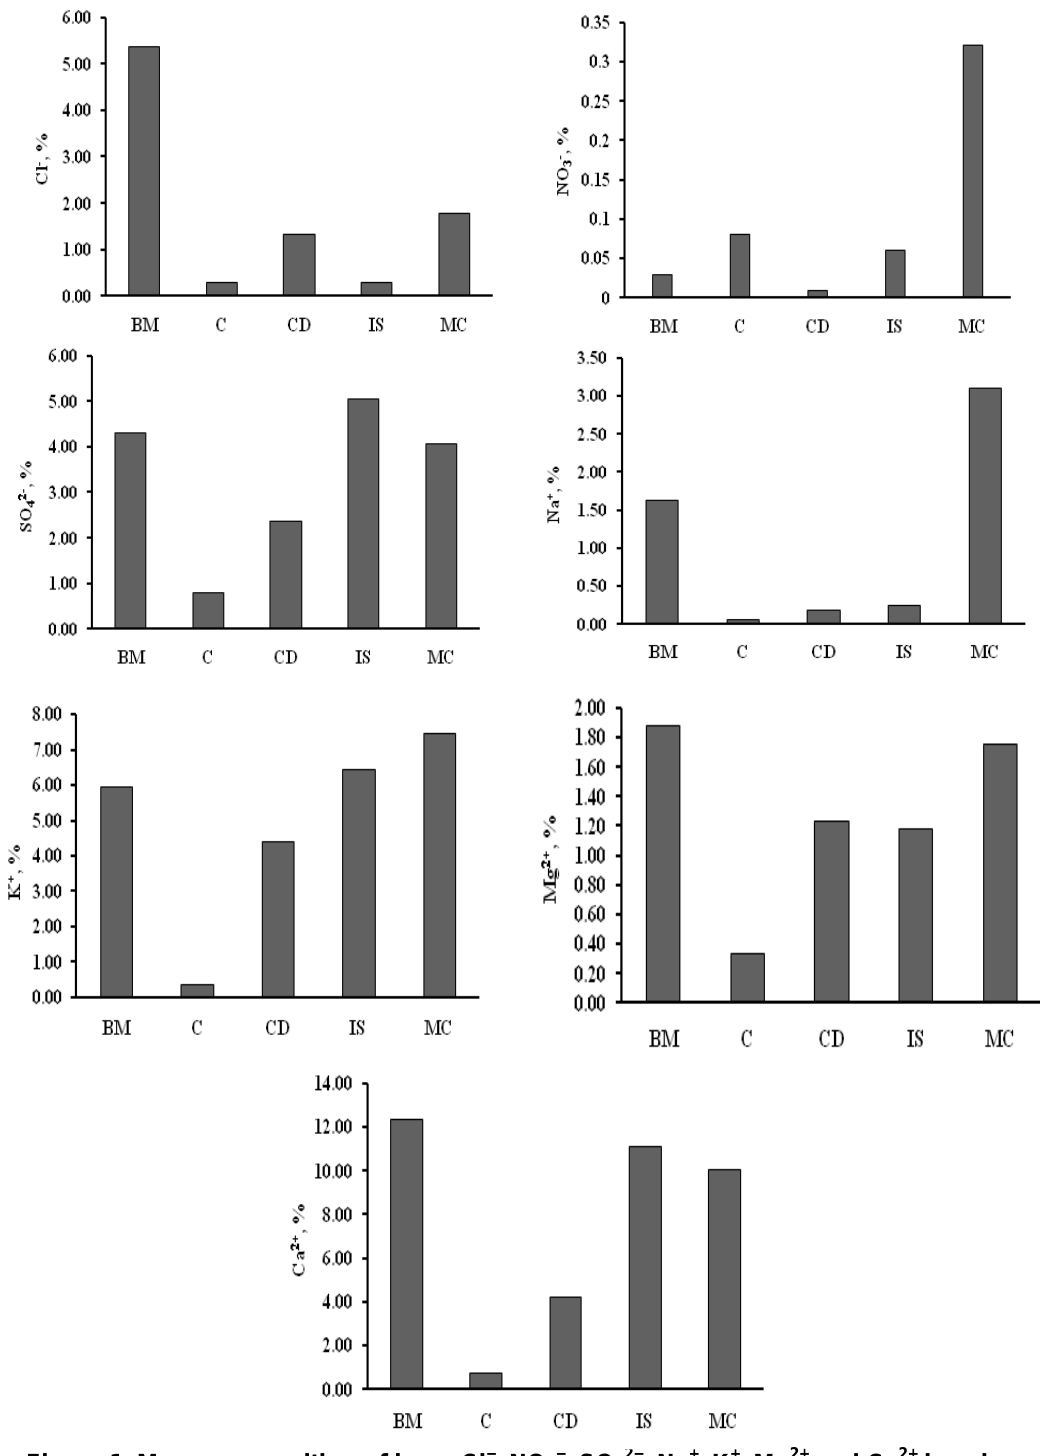
Figure 1. Mean composition of ions: Cl − , NO 3− , SO 42− , Na + , K + , Mg 2+ and Ca 2+ in ash residues, that is, biomass, coal, cow dung, incense and mosquito coil BM: Biomass; C: Coal; CD: Cow dung; IS: Incense; MC: Mosquito